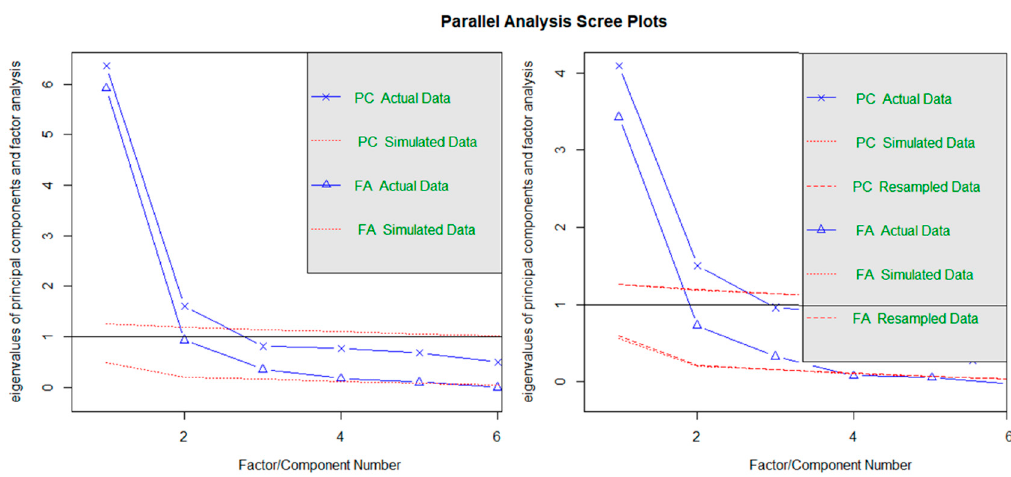
Figure 4. Parallel analysis results: ( a ) Original Principal component and parallel factor analysis with eigenvalue simulated from random normal data; ( b ) Principal component and parallel factor analysis correct eigenvalues obtained from resampling from original data.